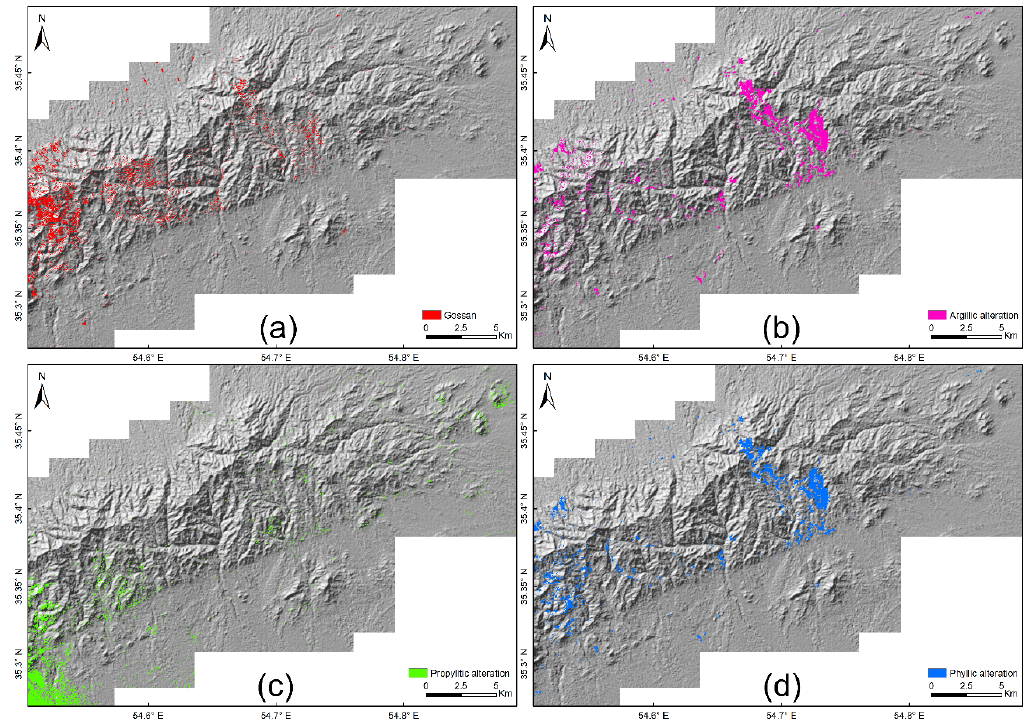
Figure 11. Anomalous pixels of di ff erent MNF components determined using the C-A plots for